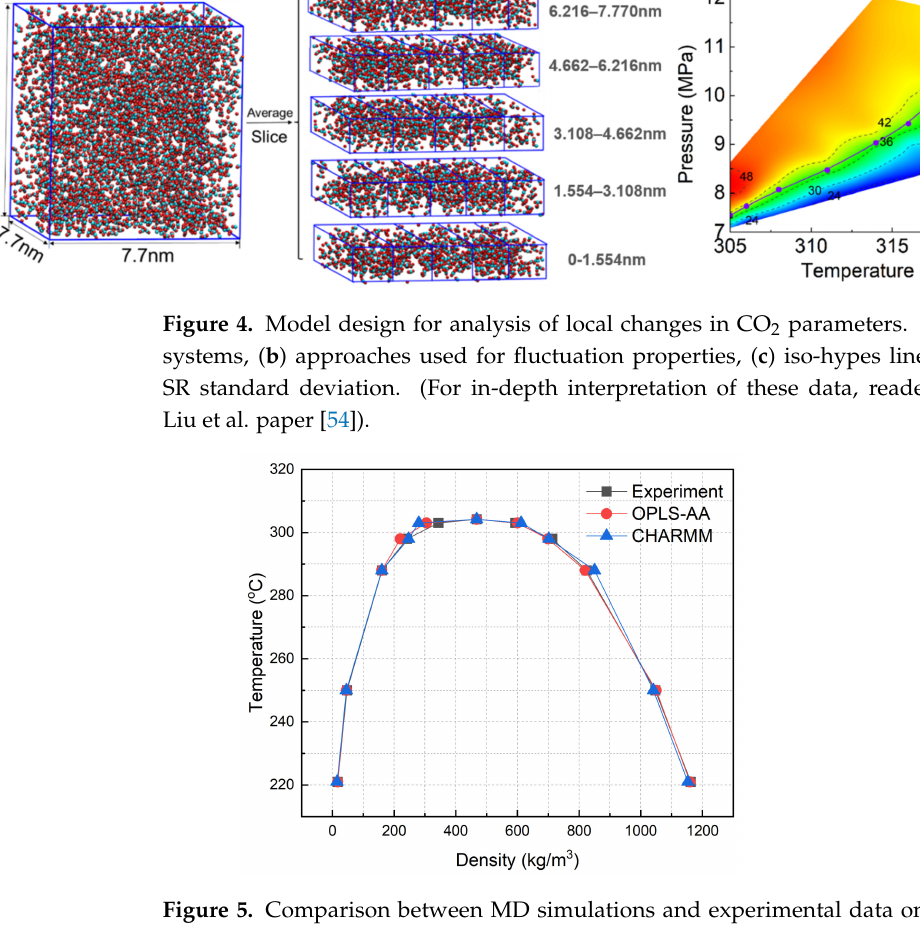
Figure 5. Comparison between MD simulations and experimental data on coexistence densities of CO 2 nearby critical point. (For in-depth interpretation of these data, readers are referred to the Liu et al. paper